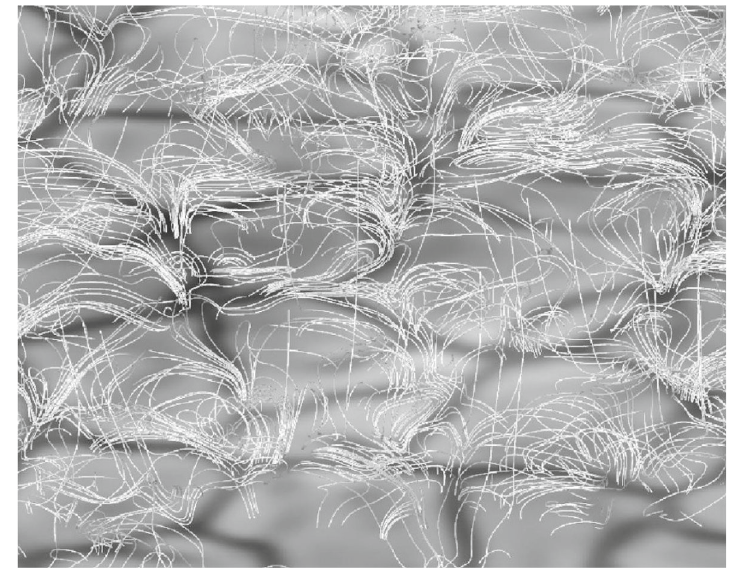
Fig. 39 Magnetic field lines overlying a map of the vertical velocity in the solar photosphere. The image shows the common occurrence of low-lying loop-like structures straddling one or more granules. Image reproduced with permission from Abbett (2007), copyright by AAS